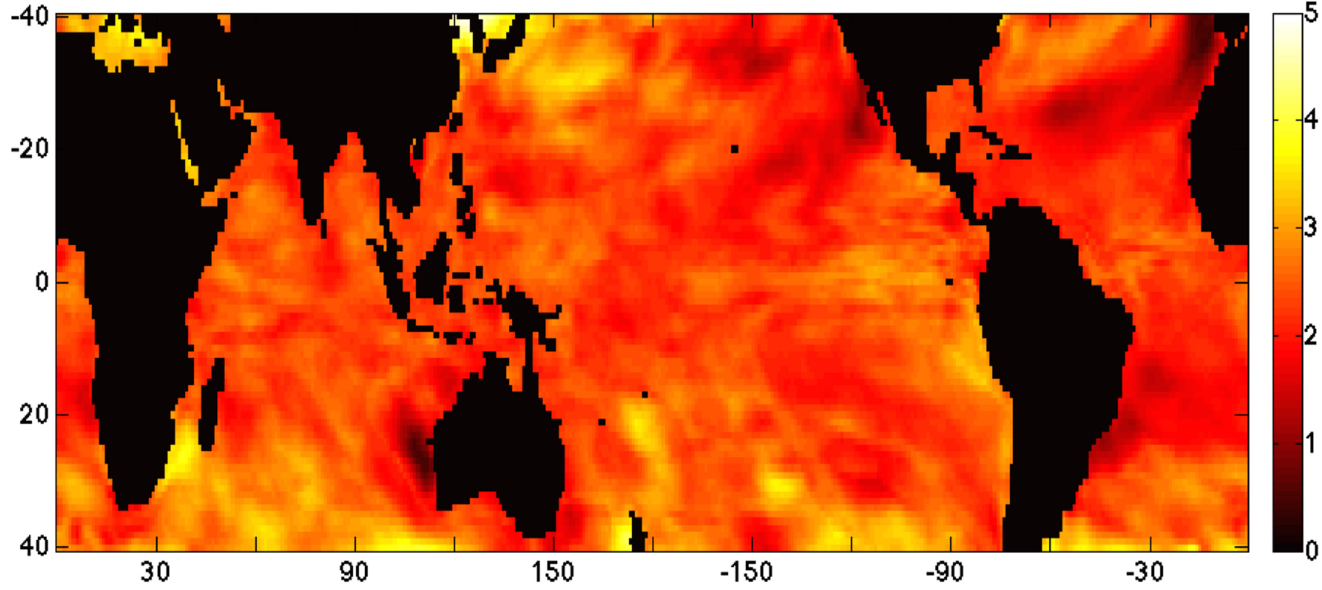
Fig 1. Map of Spatial Heterogeneity in Sea Surface Temperature Change from 2010 – 2100. The difference in average maximum sea surface temperatures from time period 2006 – 2010 to 2096 – 2100 is shown in the above map, calculated from five-year averages from the NCAR CESM1 RCP8.5 scenario. Scale indicates magnitude of change from low (dark red) to high (white) in °C. Landmasses are black.